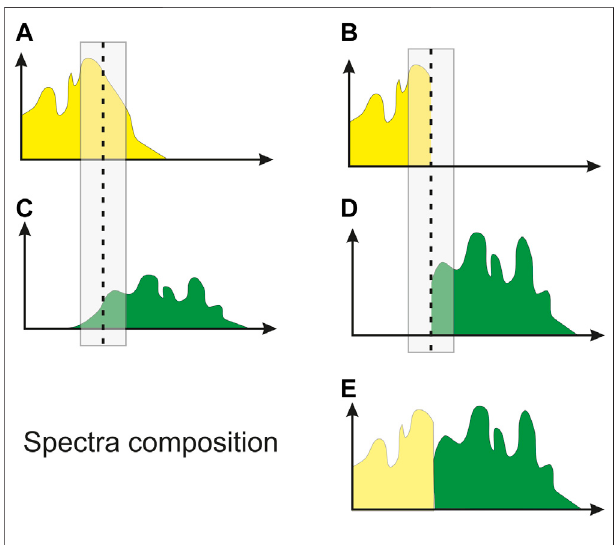
FIGURE10| Theaveragesoftwopartiallyoverlappingspectra (A,C) are evaluated in a common window, rescaled to be similar and clipped at the window center (B, D) and merged into a single, broader